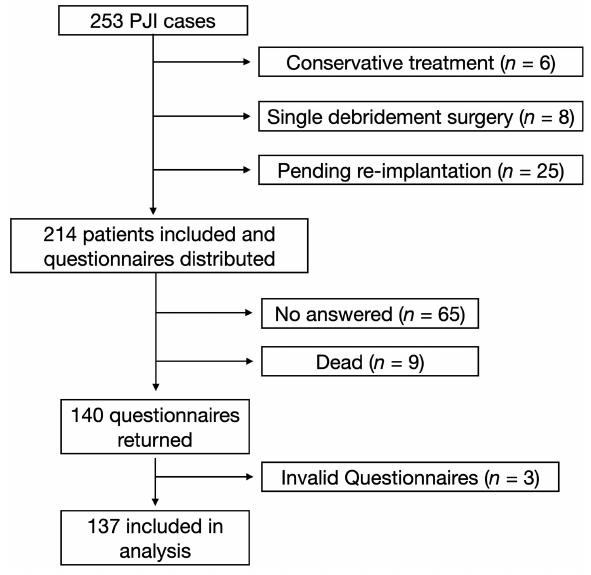
Figure 1. Flow diagram of the current study.